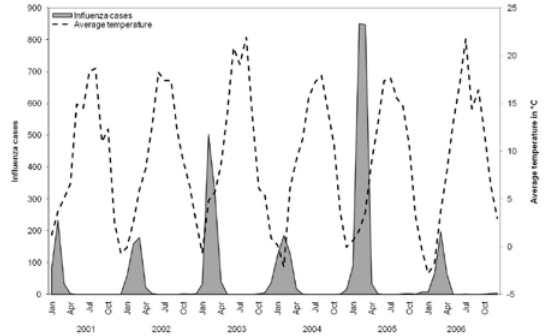
Figure 2. Influenza cases and average environmental temperature in Baden-Wuerttemberg, Germany, 2001-2006.